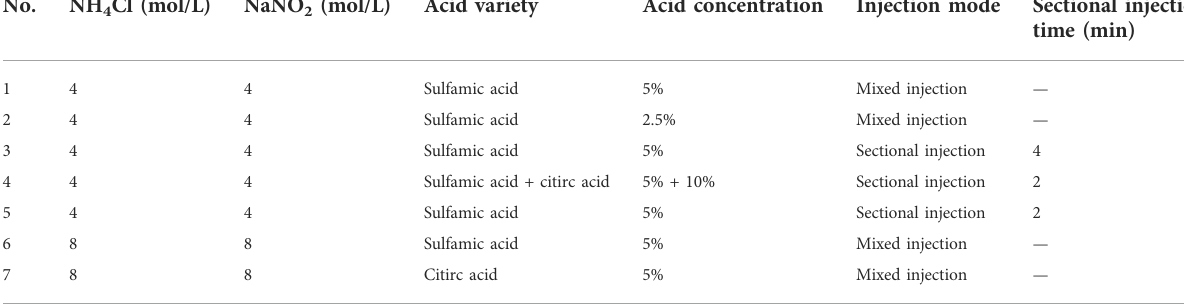
TABLE 3 The hydrate exploitation schemes of seven experiments.